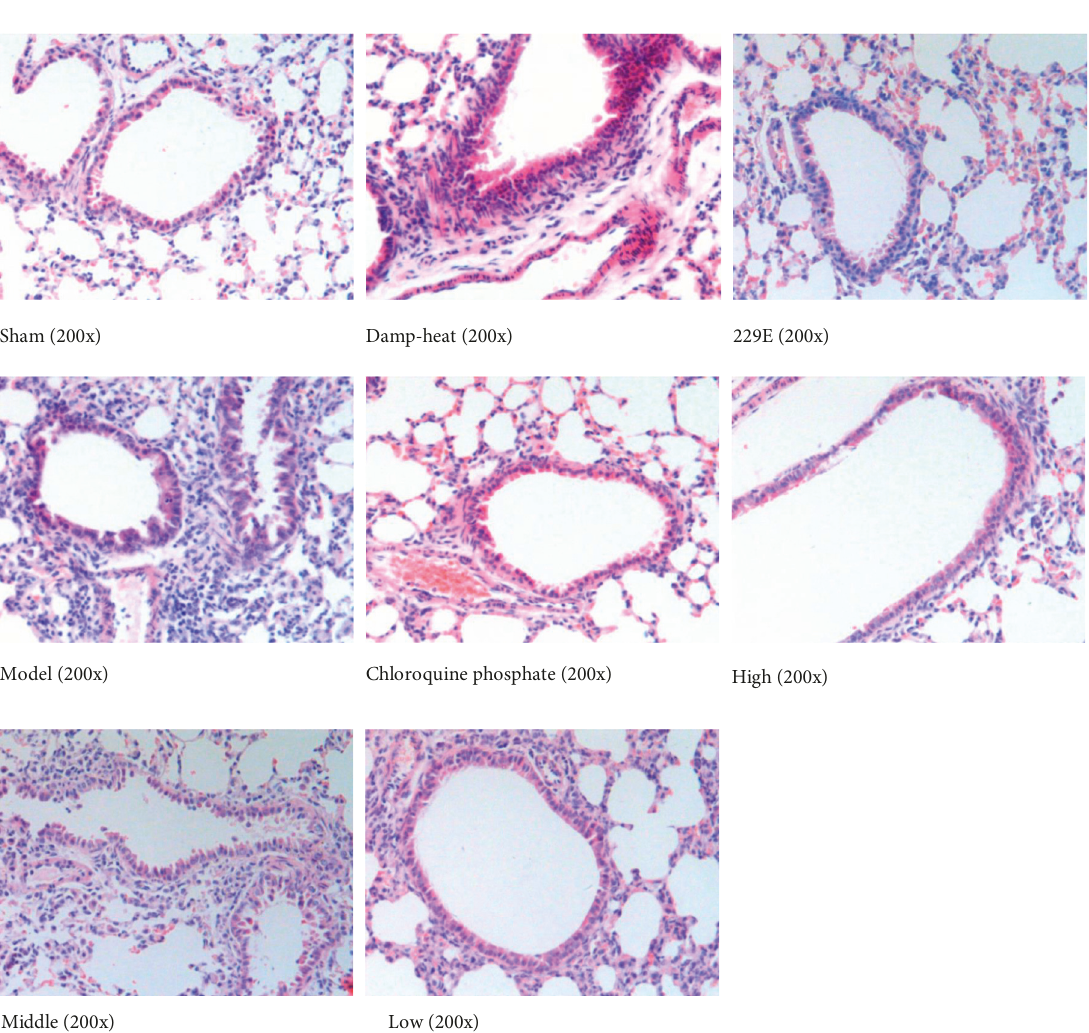
Figure 1: Effect of XQKGG on HCoV-229E induced pulmonary histopathology in mice. Pulmonary structure and tissue of bronchiole and pulmonary interstitial inflammatory infiltration in each group. There was less inflammation and structure destroyed in XQKGG